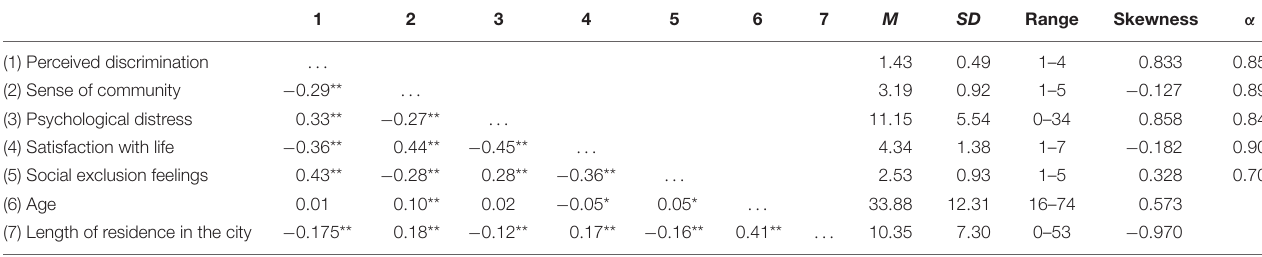
TABLE 1 | Correlations, descriptive statistics and Cronbach’s alpha for the study